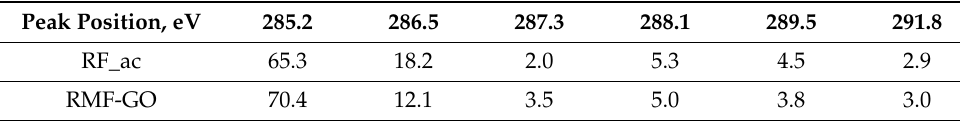
Table 4. Distribution (%) of the carbon groups.